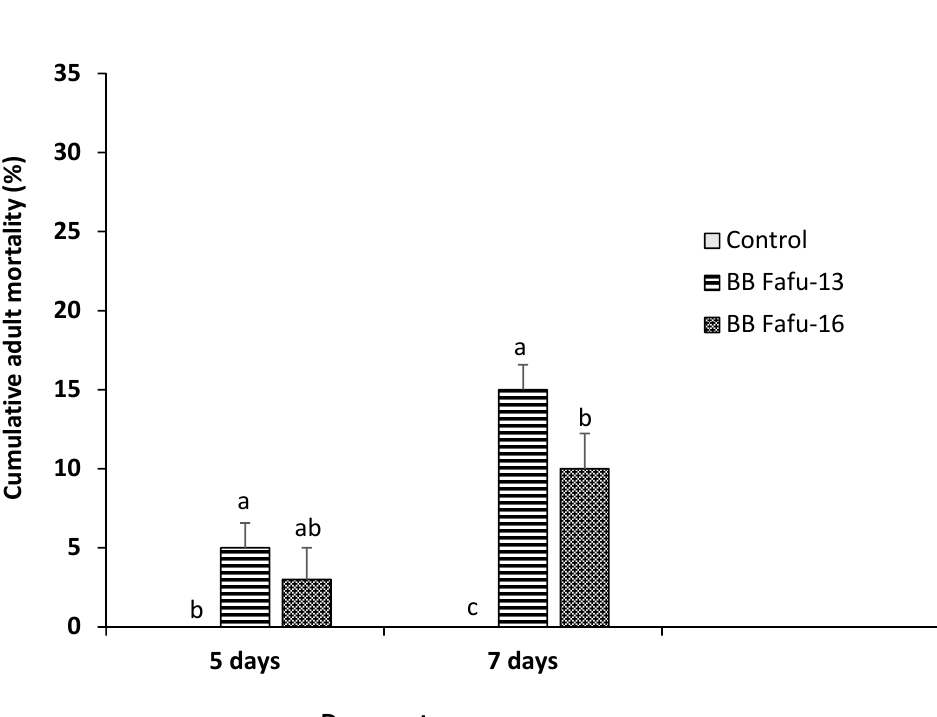
Figure 3. Cumulative adult mortality percentage of Diaphorina citri at 5- and 7-days post-exposure to treatment with Citrus limon plants challenged by endophytic Beauveria bassiana (BB Fafu-13 and BB Fafu-16) and the control. Bars ( ± SE) with di ff erent letters within the same assessment date indicate significant di ff erences among treatments at p = 0.05 (LSD after repeated-measures One-way ANOVA).